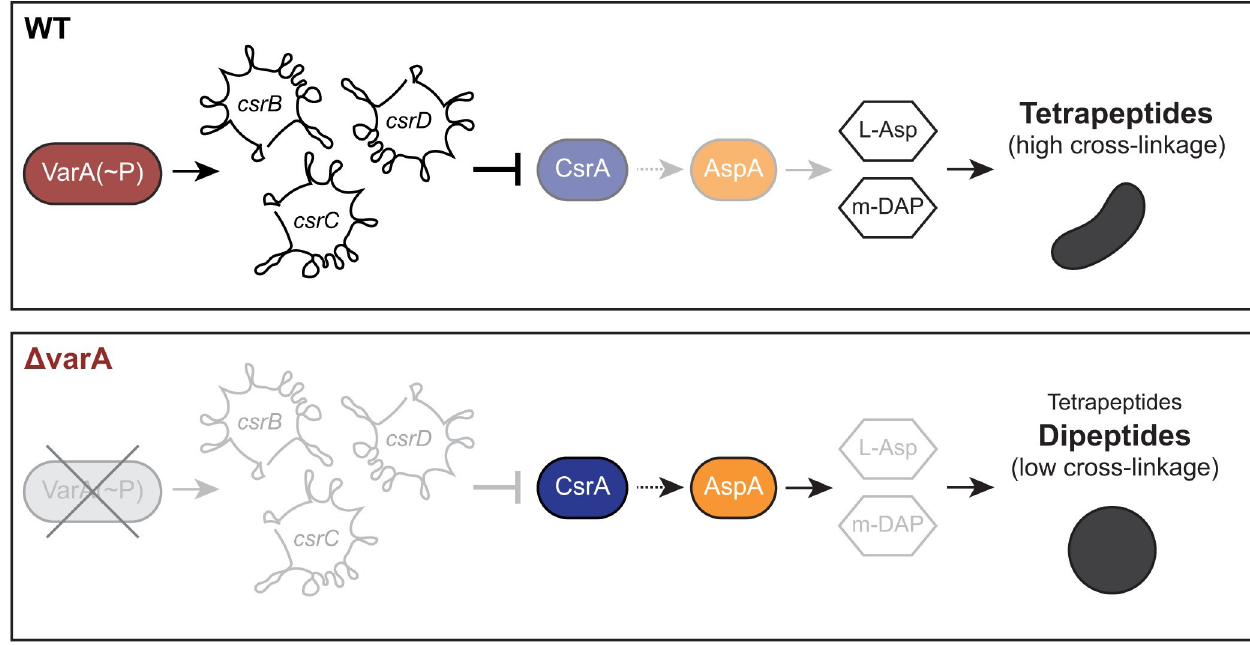
Fig 6. Model of VarA-CsrA signaling and impact on cell shape. For the WT, phosphorylated VarA [VarA(~P)] promotes the transcription of the sRNAs csrB-D , which sequesters CsrA. L-Asp and m-DAP levels are maintained resulting in normal PG and cell shape. In the absence of varA , the lack of the scavenging sRNAs results in increased CsrA activity and (directly or indirectly, as shown by the dashed arrow) overproduced AspA, which reduces L-Asp levels and impairs m-DAP biosynthesis. The PG therefore contains dipeptides, while tetrapeptides are reduced, leading to a reduction of cross-links and therefore cell rounding.